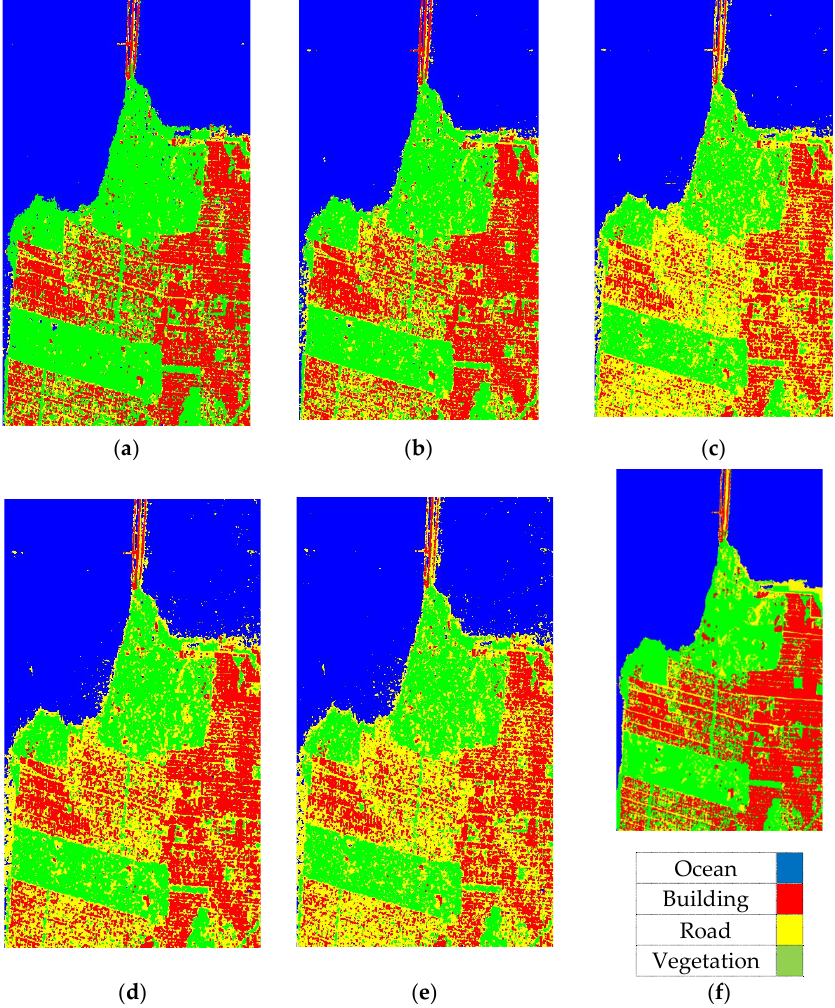
Figure 11. Classified images of architectures. ( a ) MOBChOA-DCNN; ( b ) CapSA-DCNN; ( c ) BWO- DCNN; ( d ) GWO-DCNN; ( e ) BBO-DCNN; ( f ) Ground truth image.